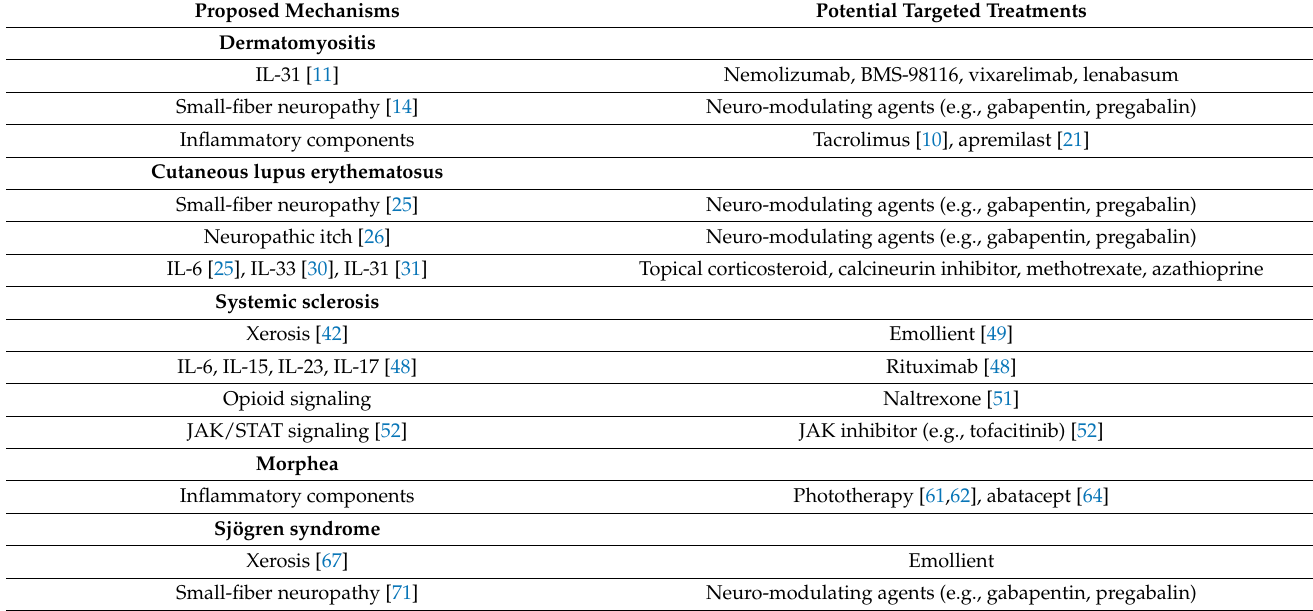
Table 1. Summary of studies of possible mechanisms for ACTD-related pruritus and potential targeted